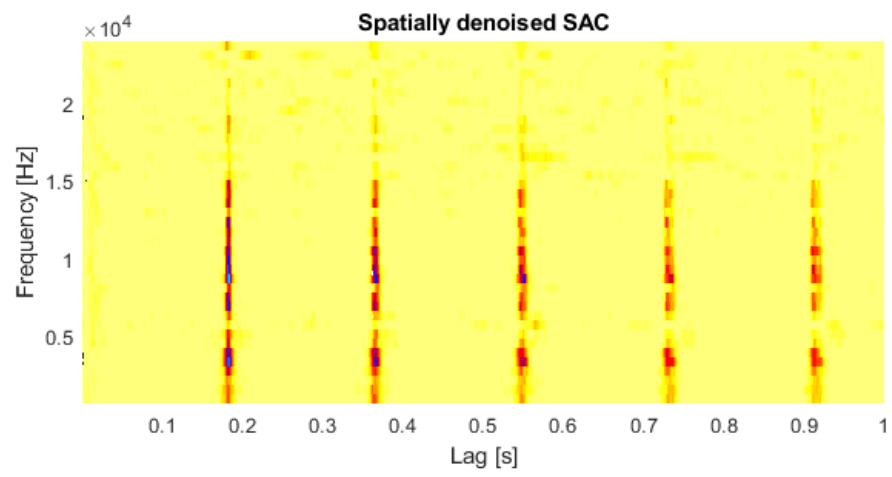
Figure 15. Spatially denoised spectral autocorrelation map. Vectors of the denoised map have been averaged along the frequency axis, which forms a single enhanced autocorrelation function (EACF) (see Figure 16). The maximum value of this function (the value at the first peak) indicates the fundamental period of the cyclic component equal to 0.18 s, which translates to the fault frequency of 5.46 Hz.